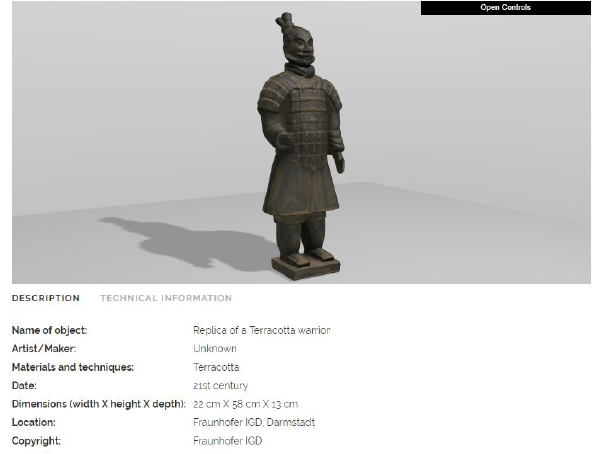
Figure 2. Replica of a Terracotta warrior and additional metadata presented in a Web3D browser environment